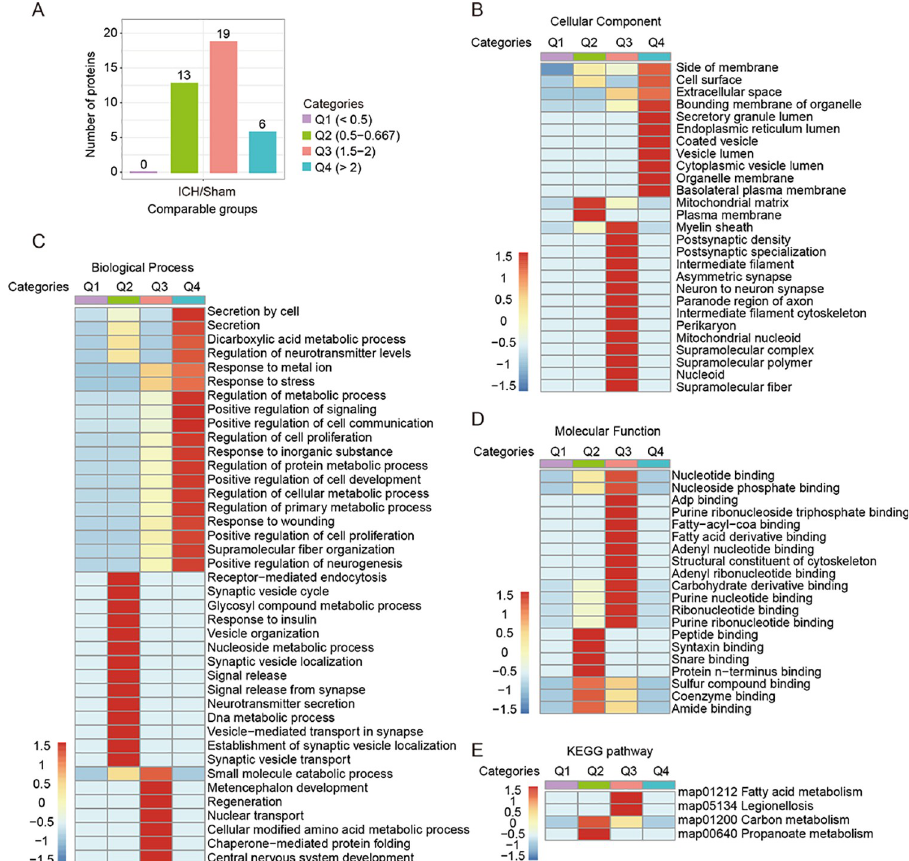
Fig 3. Four clusters of differentially expressed proteins were analyzed and annotated. (A) The number of differentially succinylated sites (Fisher’s exact test, P < 0.05) in each cluster after ICH. (B-D) GO analysis at the level of cellular component, biological process, and molecular function enriched in each cluster after ICH. (E) KEGG pathway analysis of each cluster after ICH.